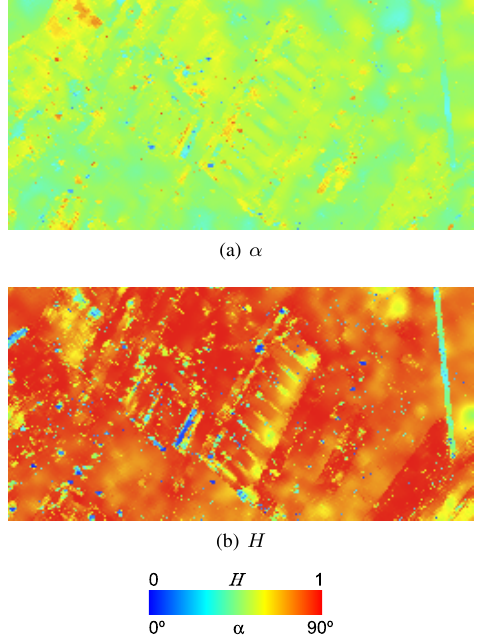
Figure 3: Images of the H/α parameters computed on the filtered